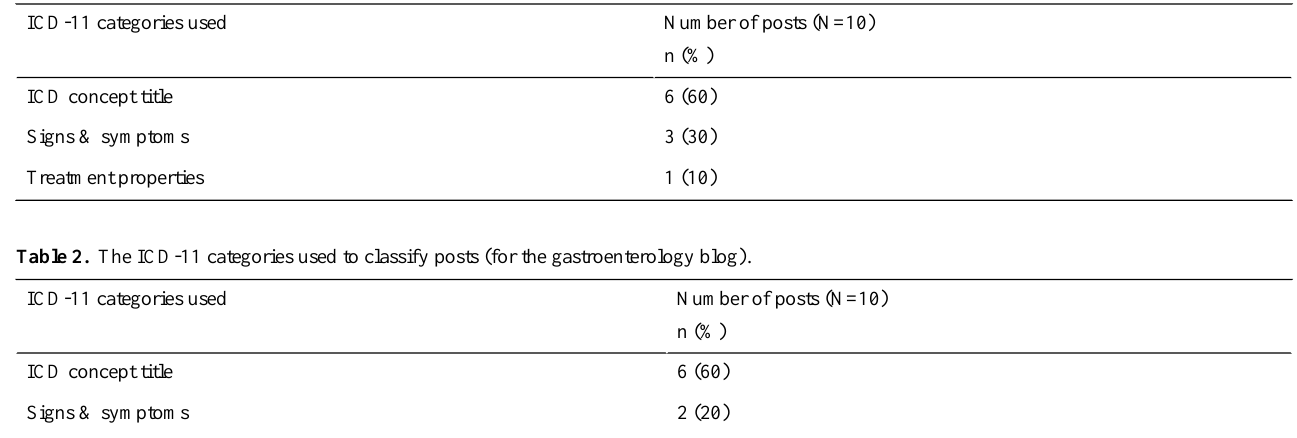
Table 1. The ICD-11 categories used to classify posts (for the cardiology blog).